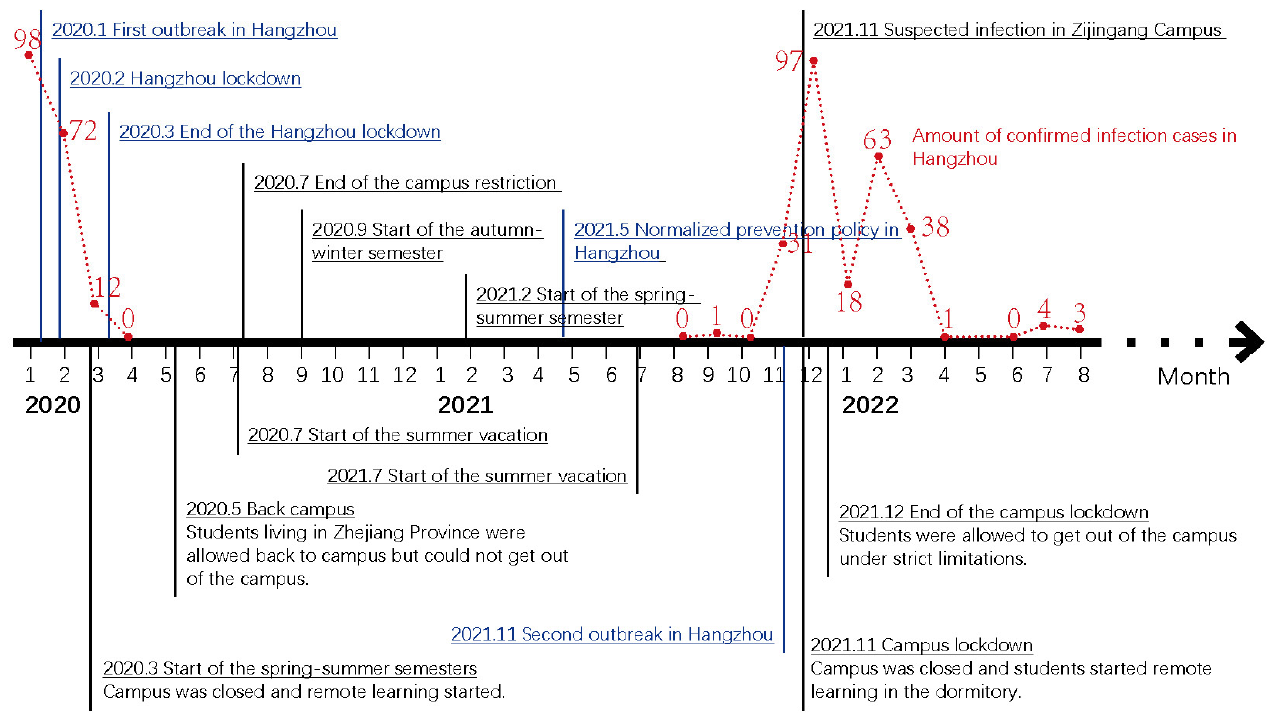
Figure 2. Timeline of pandemic events in Hangzhou and the corresponding campus operations of Zhejiang University.